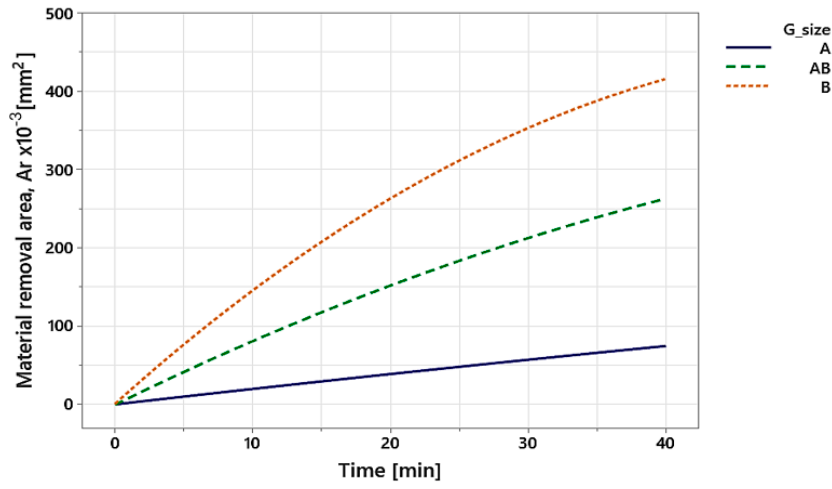
Figure 10. Material removal area of the three abrasive blends with time variation.